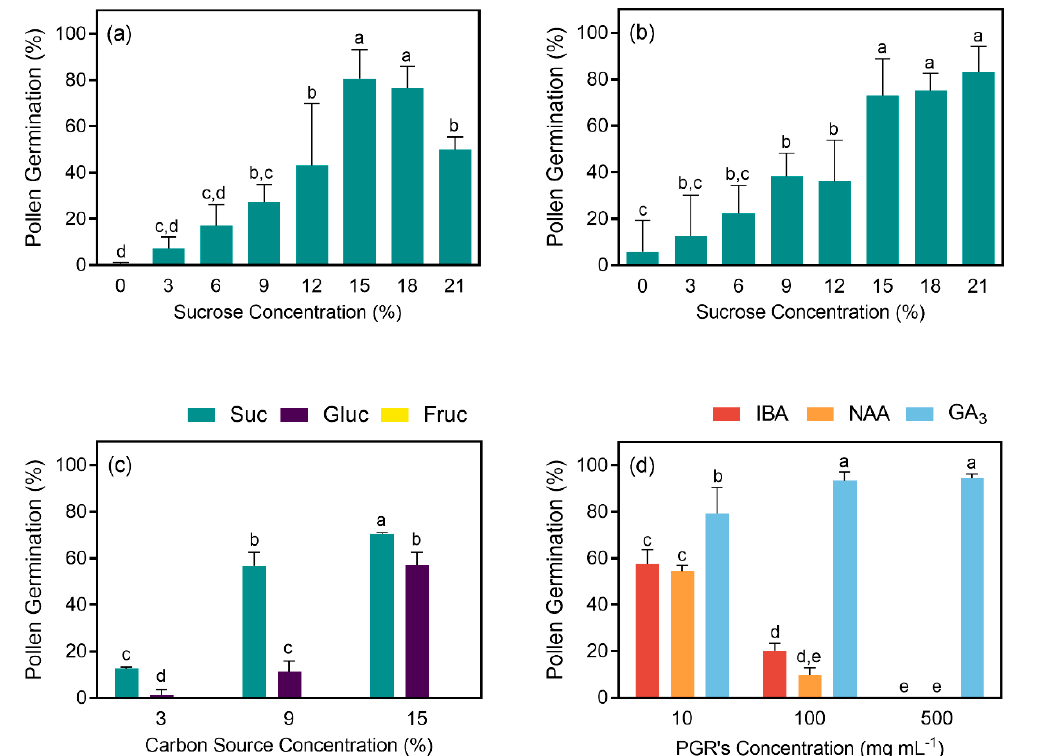
Figure 4. ( a ) Effect of different sucrose concentrations (0, 3%, 6%, 9%, 12%, 15%, and 18%) on pollen germination rates after 6 h and ( b ) 24 h; ( c ) effect of different carbon sources (sucrose, glucose, and fructose) at three different concentrations (3%, 9%, and 15%) on pollen germination after 24 h; ( d ) effect of plant growth regulators (indole-3-butyric acid (IBA), 1-naphthaleneacetic acid (NAA), and gibberellic acid (GA 3 )) on germination rates at different concentrations (10, 100, and 500 mg L − 1 ) after 24 h. Values (%) are means ± standard deviations, n = 5 , different letters indicate significant differences between treatments at p ≤ 0.05.